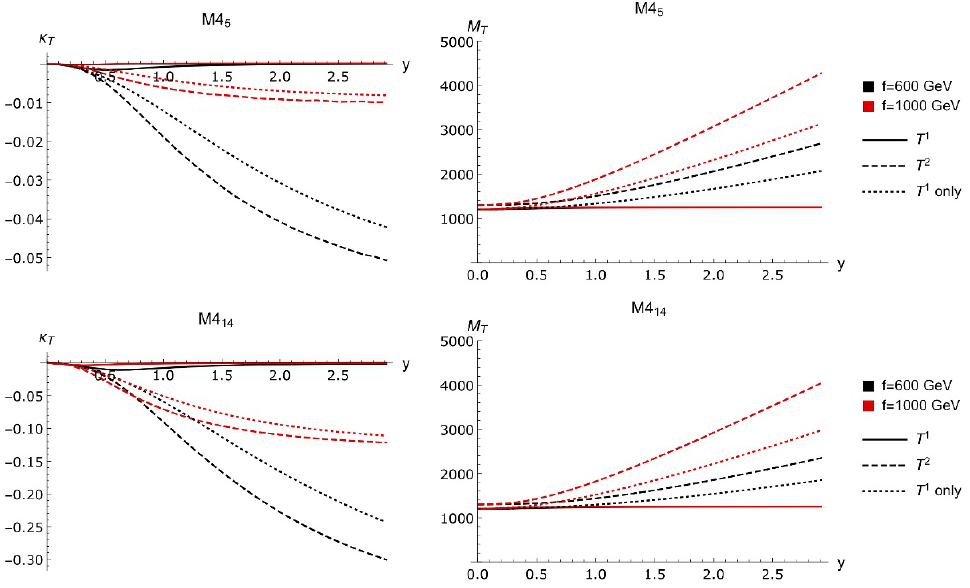
= 1200 GeV, M (cid:9) = 1300 GeV, and y = 1 ; 3. 1 2